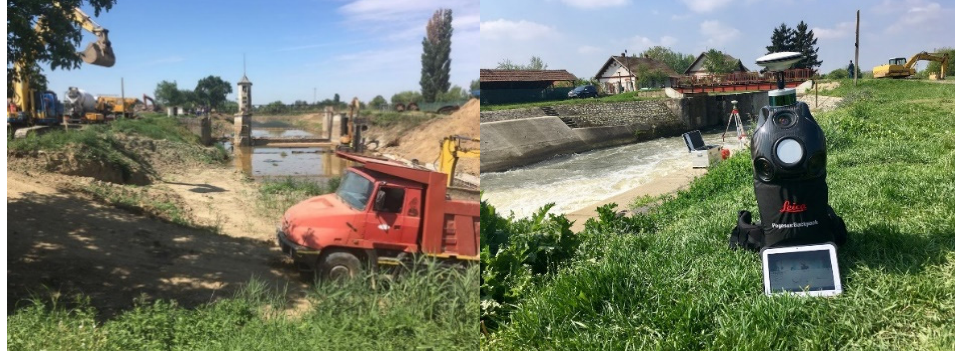
Figure 2. Scanning of the Sânmihaiu Romanian Lock under renovation using Leica Pegasus Backpack equipment.